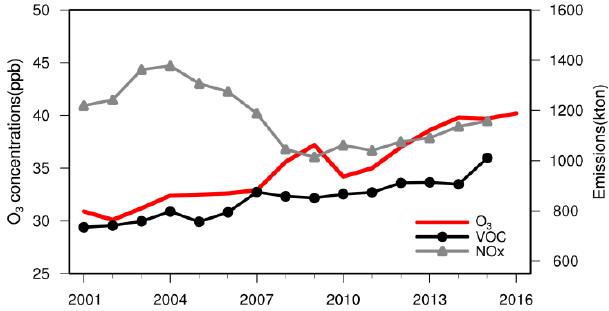
Figure 3. Annual O 3 concentrations (red) and total emissions of VOC (black) and NOx (gray) which are precursors of O 3 (units: kton = 1000 ton). Table 1. Correlation coefficients, coefficients of determination, and trends of O 3 and precursors in different periods. R